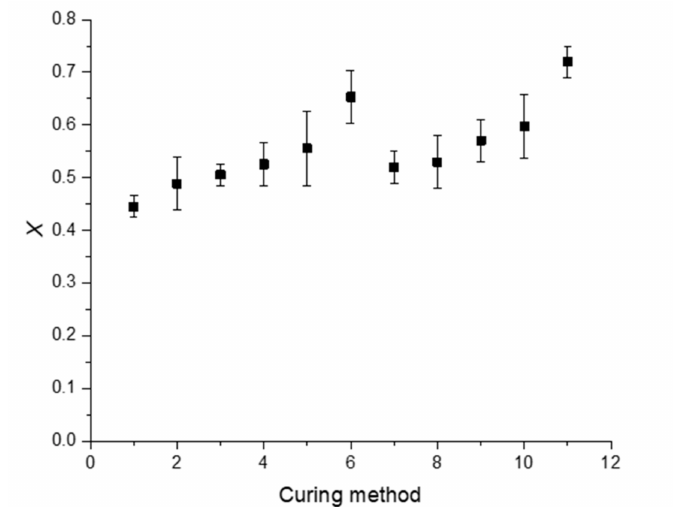
Figure 4. Degree of conversion of C = C polyester bonds ( X ) according to the curing parameters.